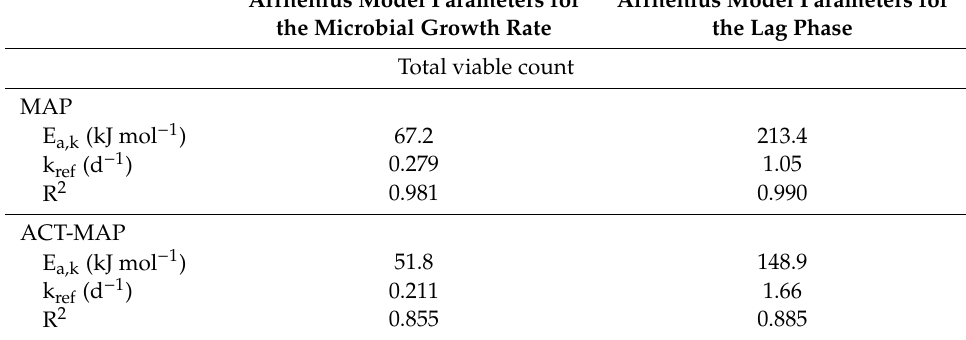
Table 2. Kinetic parameters of the Arrhenius model for the microbial growth rate and lag phase for the total viable count, Pseudomonas spp. and Enterobacteriaceae spp. in gutted sea bass during the isothermal storage at 0–10 ◦